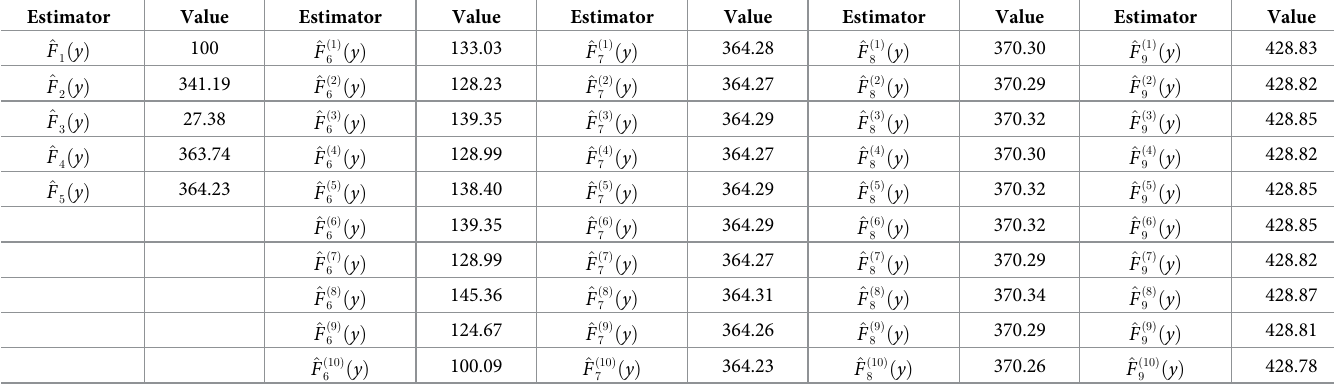
Table 13. PREs of distribution function estimators using Population